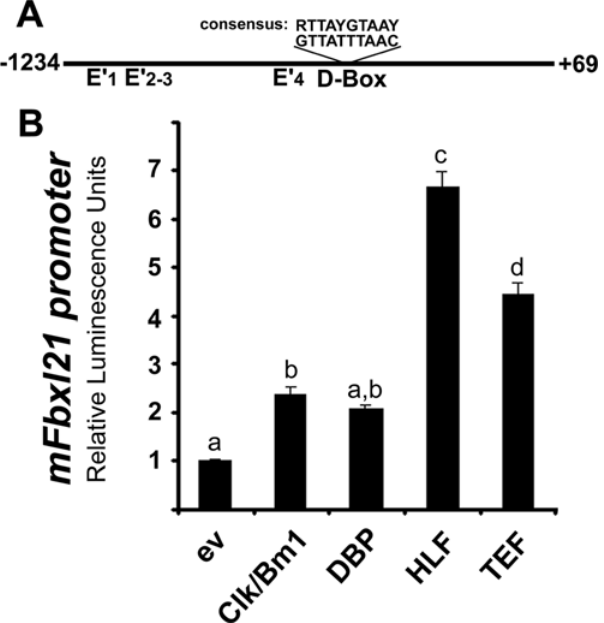
Figure 6. mFbxl21 is a clock-controlled gene. A . Schematics depicting the promoter region of the mouse Fbxl21 gene, E’ indicate non-canonical E-Box motifs, D-Box indicates a putative response element for the PAR-bZIP proteins. B . The mouse Fbxl21 gene is responsive to both CLK/BM1 and the PAR-bZIP transcription factors. Transfection conditions per well: 50 ng of Fbxl21 promoter reporter, 50 ng of b-Gal reporter and either 100 ng of mClock + 100 ng of mBmal1 or 100 ng of each of the PAR-bZIP transcription factors and/or necessary amount of empty vector to make a final amount of 300 ng. Data in A/B are mean 6 SEM of one triplicate representative from 3 replicate experiments. Different letters above bars indicate significantly different groups (p , 0.05).